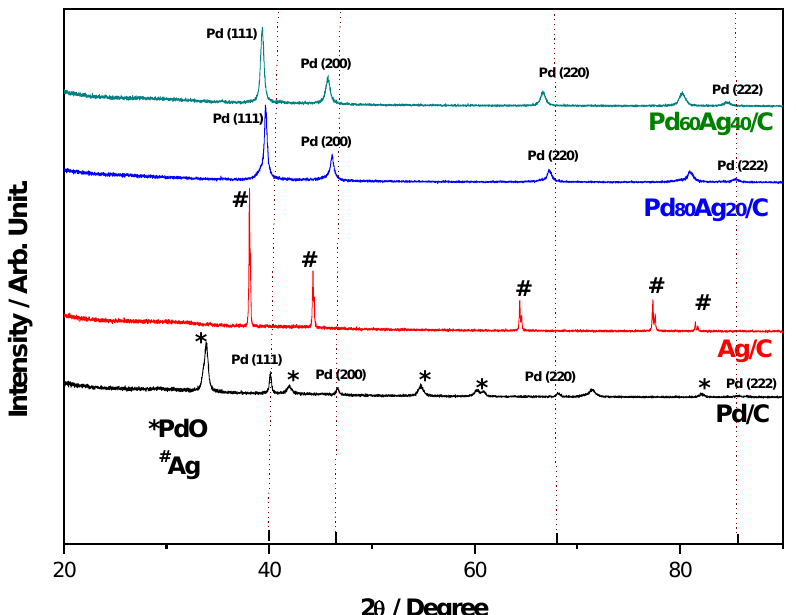
Figure 1. X-ray diffraction patterns of the electrocatalysts 40% metals-based/C; 2 θ range 20–90 ◦ registering at 0.01 ◦ steps with Cu K α 1 radiation (1.54060 Å). The predicted diffraction peaks for Ag, Pd, and PdO were also included.